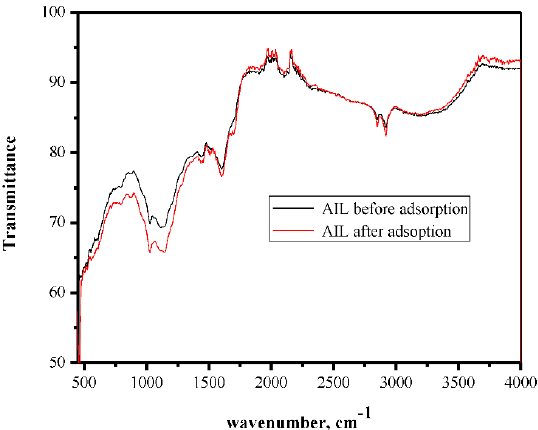
Figure 1. FT-IR spectrum of Azadirachta indica leaves’ powder (AILP) before and after adsorption.